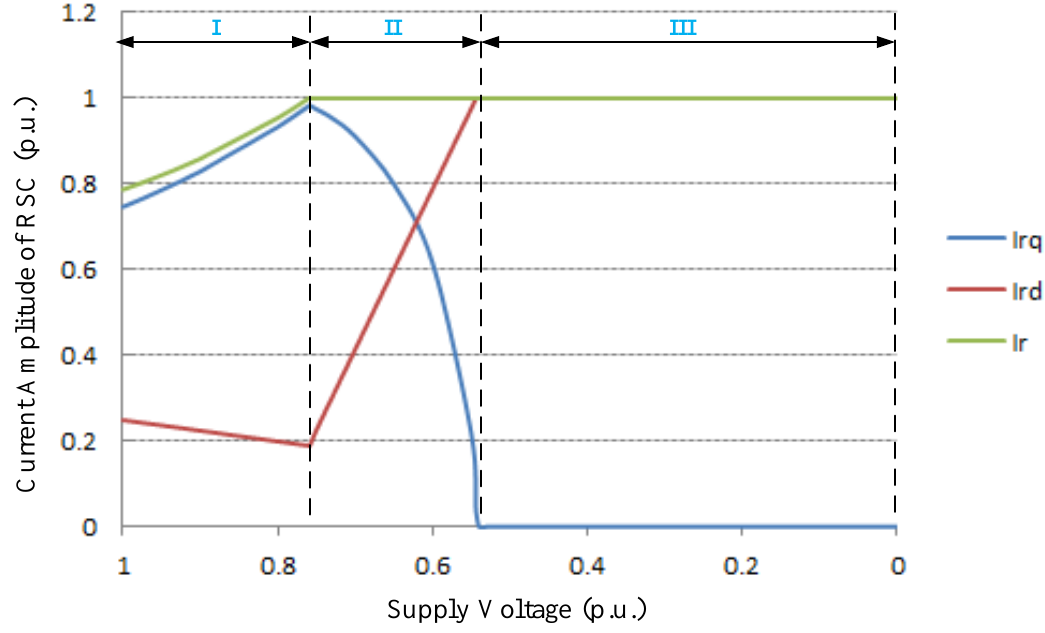
Figure 9. The coordinated control strategy of the active and reactive current of